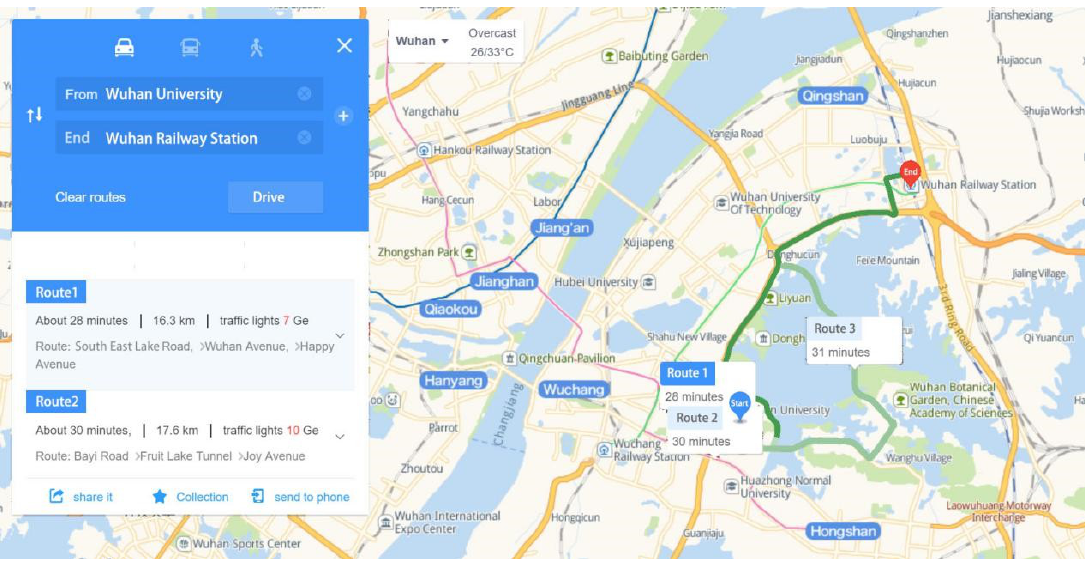
Figure 1. Recommended travel routes of AMap.